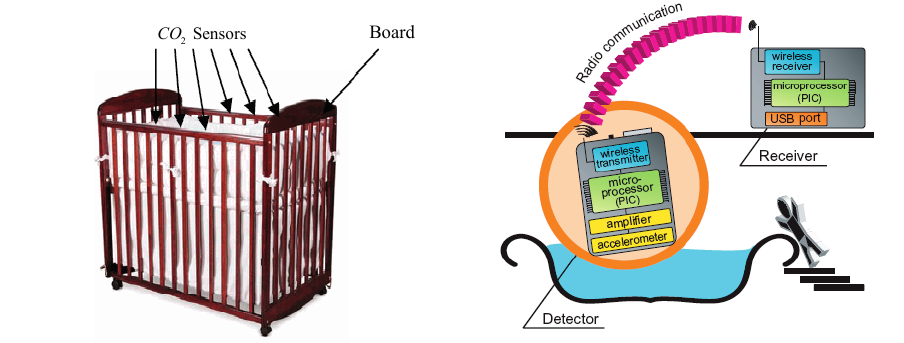
Figure 12. A crib with CO 2 sensors mounted around the baby bed ( left ) [13] Copyright © 2007 IEEE; and a drowning prevention system based on a wireless accelerometer ( right ) [24]. Copyright © 2007